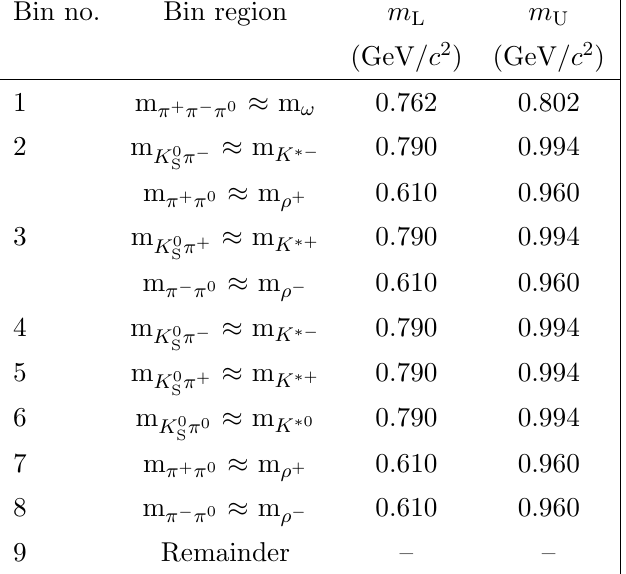
(cid:25) + (cid:25) (cid:0) (cid:25) 0 phase space. Here m L and S